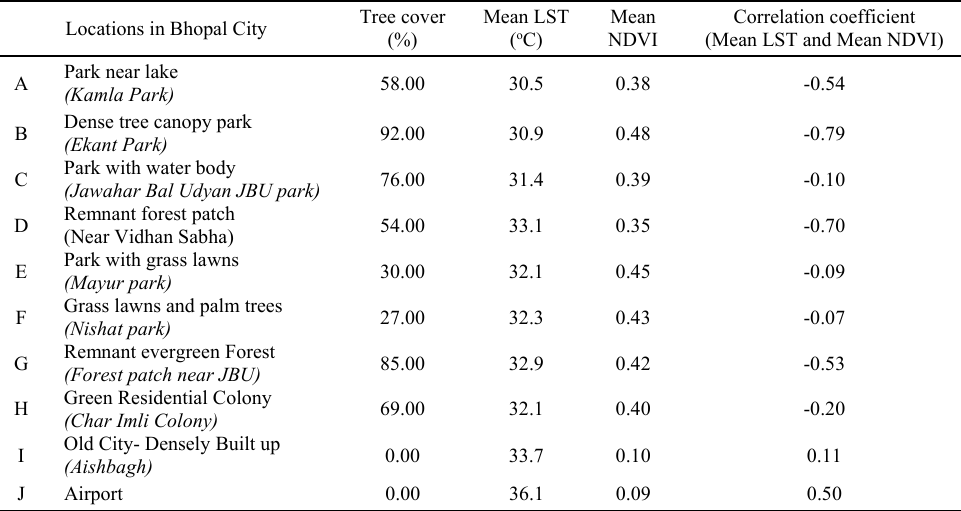
Table 3: Selected locations of vegetation and built land uses from Bhopal city Tree cover Locations in Bhopal City (%)